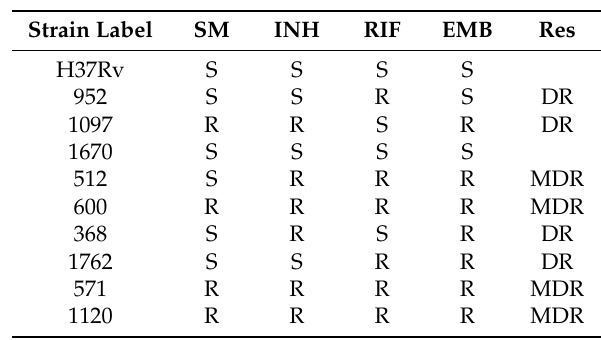
Table 1. Drug sensitivity test results for M. tuberculosis strains used for the following resazurin microtiter assay (REMA): sensitive (S) and resistant (R). In the last column, the level of resistance is assigned as drug-resistant (DR) or multidrug-resistant (MDR). SM: streptomycin; INH: isoniazid; RIF: rifampicin; EMB: